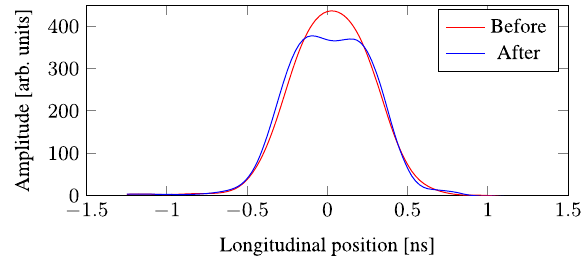
FIG. 6. The measured longitudinal profile before and after the